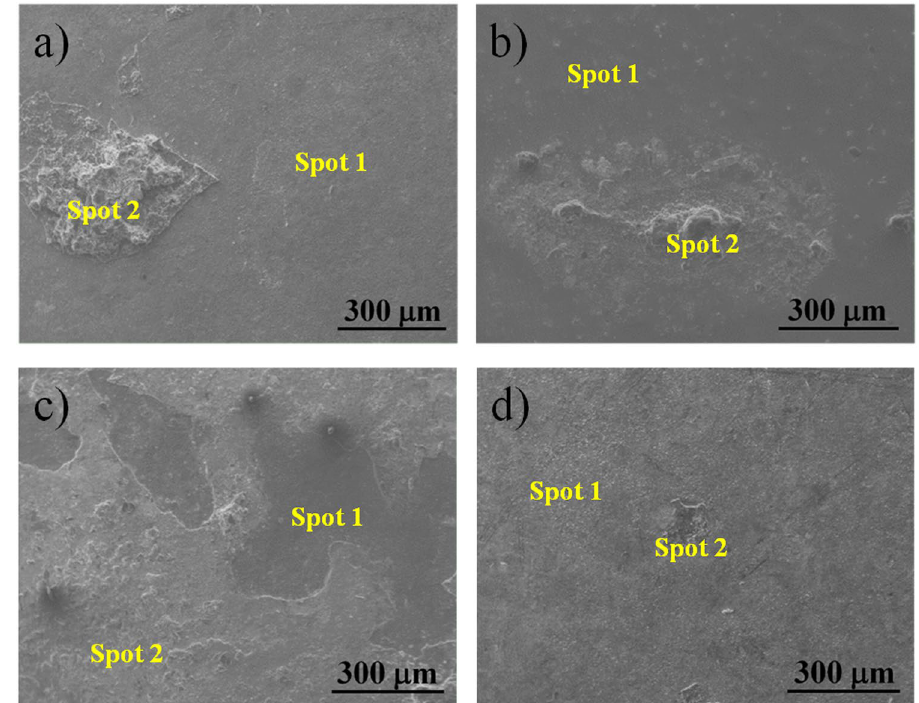
Figure 8. Surface morphology of the Ta-Hf-C samples after exposure to a mixture of pentoxide vanadium, V 2 O 5 , and sodium sulfate, Na 2 SO 4 at 700 °C; ( a ) TaC, ( b ) 70TaC-30HfC, ( c ) 30TaC-70HfC, and ( d )